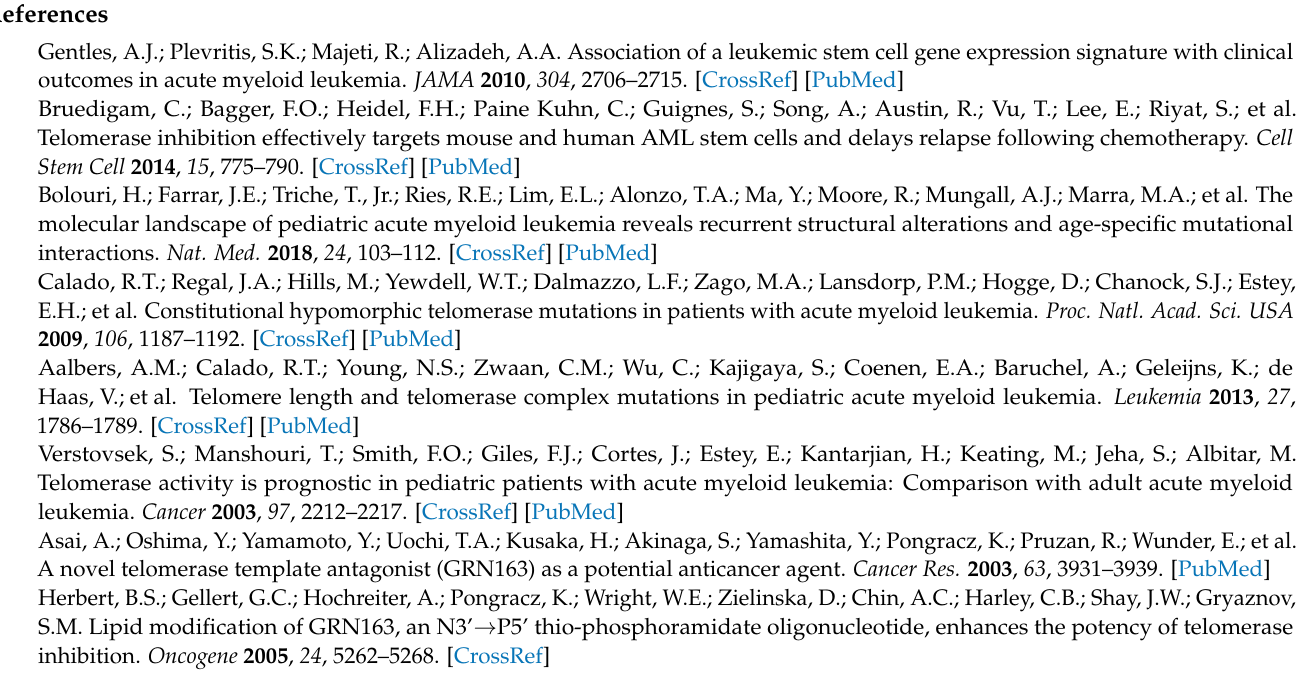
Figure S2: Imetelstat had minimal effect on the percentage of dead cells in pediatric AML PDX lines. Figure S3: Effect of imetelstat on the viability of CD34+CD38low population in normal pediatric bone marrow samples at 96 h post treatment. Figure S4: Representative flow cytometry plots showing the LSC (CD34+/CD38low) population. Table S1: Two-way ANOVA analysis to compare the effect between treatment groups on percentage of LSC population (CD34+CD38low population) in the terminal bone marrow samples isolated from mice treated with either single agent or in